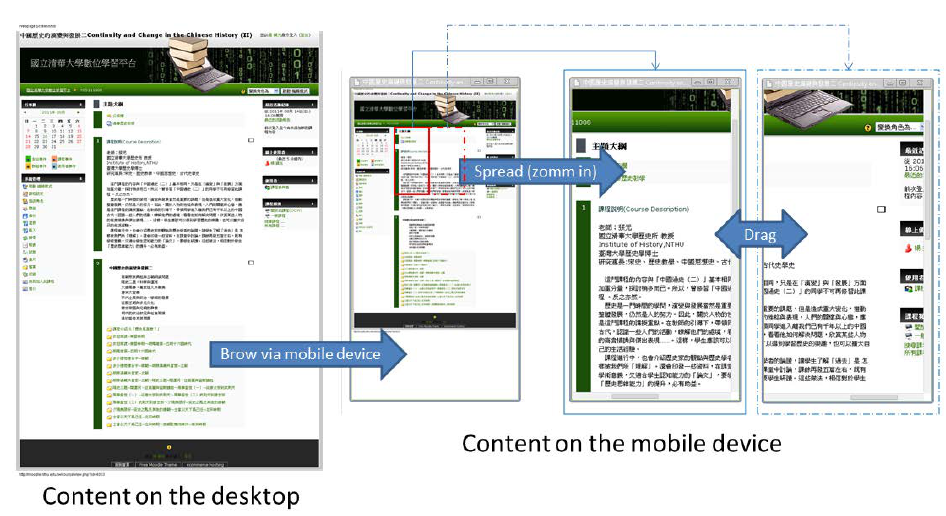
Figure 2 . Readability of Moodle-based